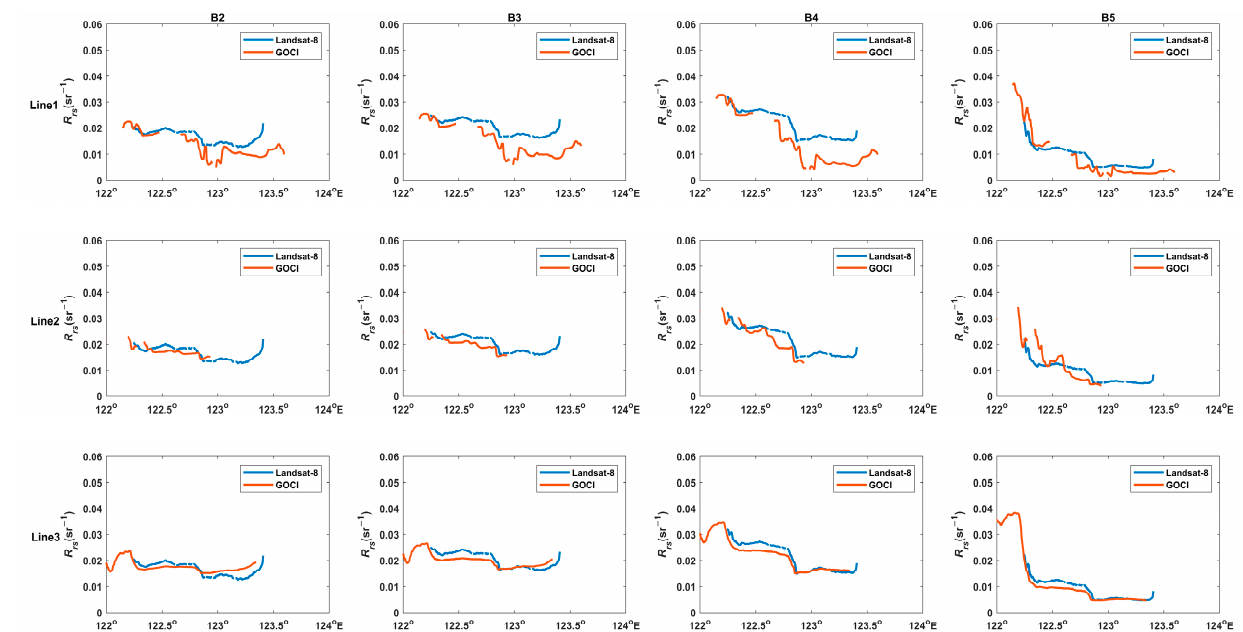
Figure 5. Comparisons between GOCI-derived R rs and L8/OLI-derived R rs along three lines. Four bands (the units are nm) are given from left to right: B2 (GOCI R rs (443) versus L8/OLI R rs (443)); B3 (GOCI R rs (490) versus L8/OLI R rs (483)); B4 (GOCI R rs (555) versus L8/OLI R rs (561)); and B5 (GOCI R rs (660) versus L8/OLI R rs (655)). Three transects from top to bottom, line1, line2, and line3, are shown in Figure 4.